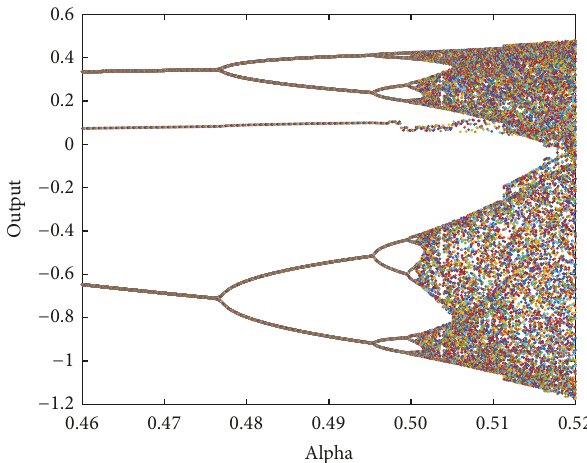
Figure 1: The bifurcation of the output with the change of 𝛼 .